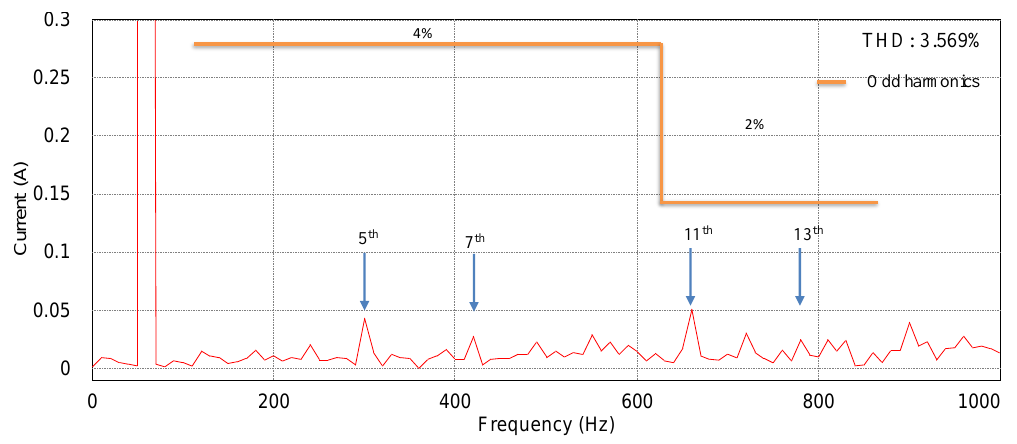
Figure 11. FFT result for grid-side a -phase current of the proposed controller under distorted grid voltages.